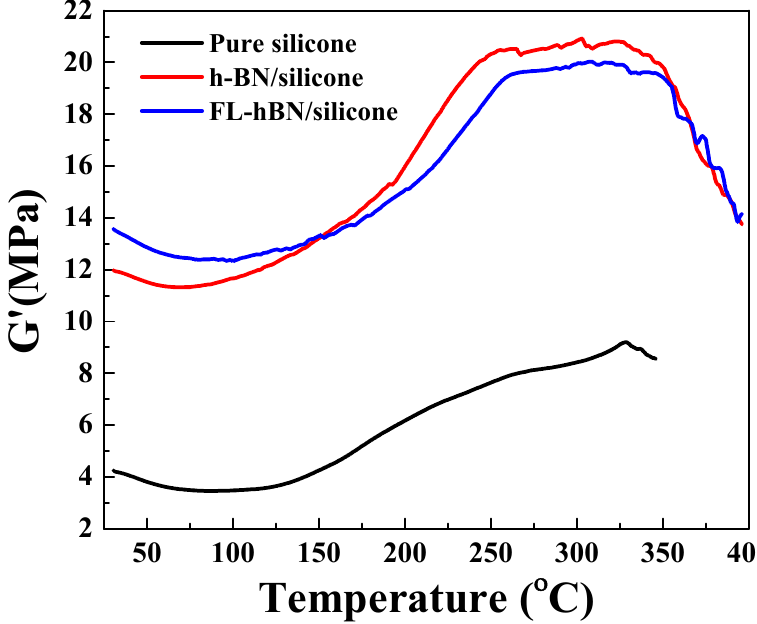
Figure 10. Dynamic mechanical analysis (DMA) curves of pure silicone, h-BN/silicone and FL-hBN/silicone composites.